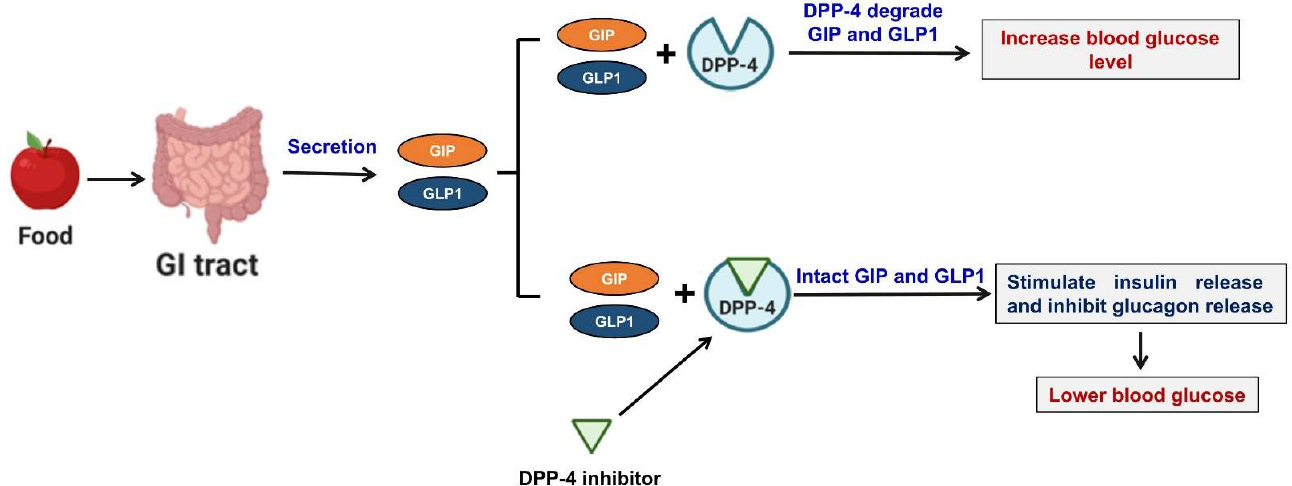
Figure 1. Proposed mechanism of DDP-4 inhibition. In response to nutrient intake and/or an enhanced BG level, incretins (GLP-1 and GIP) are released from the gastrointestinal tract. These two incretins enhance insulin synthesis and secretion and inhibit the release of glucagon, and thus, reduce BG levels in healthy individuals. However, in T2DM, DPP-4 rapidly degrades both incretins and renders them inactive. DPP-4 inhibitors act by preventing DPP-4-induced incretin degradation, increasing intact GLP-1 and GIP levels, and improving glucose homeostasis.